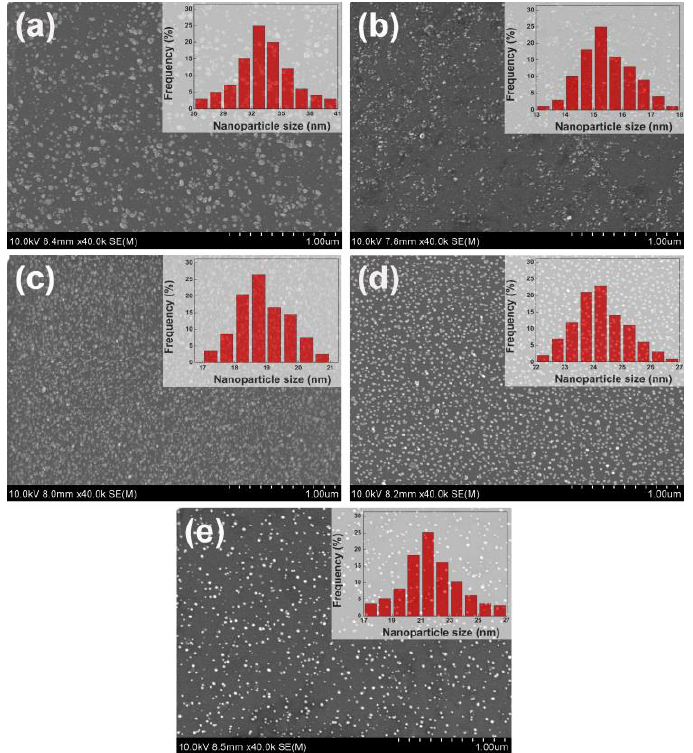
Figure 1. Scanning electron microscopy (SEM) images of ( a ) Ru, ( b ) Rh, ( c ) Pd, ( d ) Ir, and ( e ) Au nanoparticles electrodeposited on the GCE, respectively. Insets of SEM images show the corresponding particle size distribution histogram.